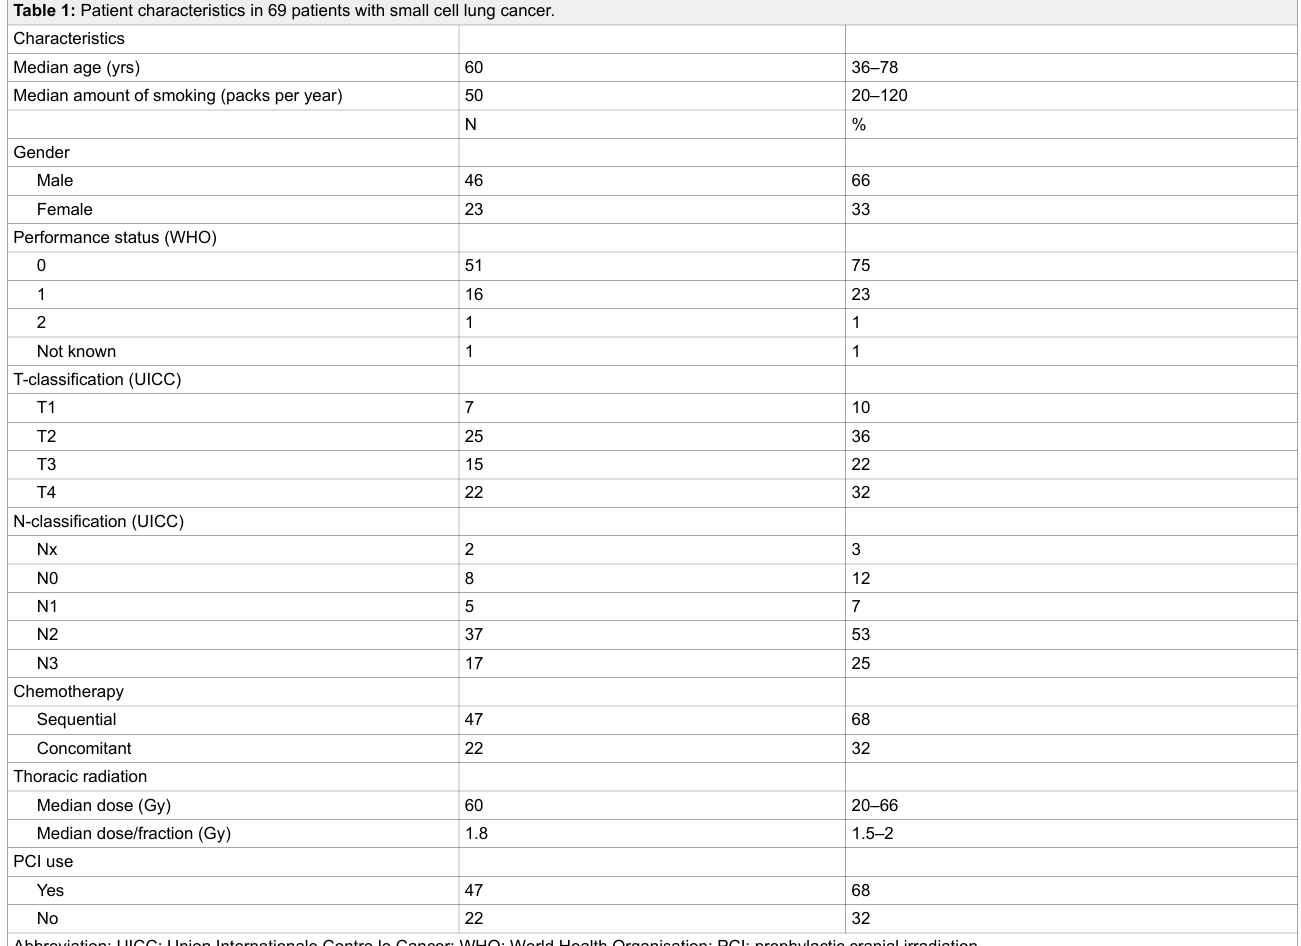
Table 1: Patient characteristics in 69 patients with small cell lung cancer.